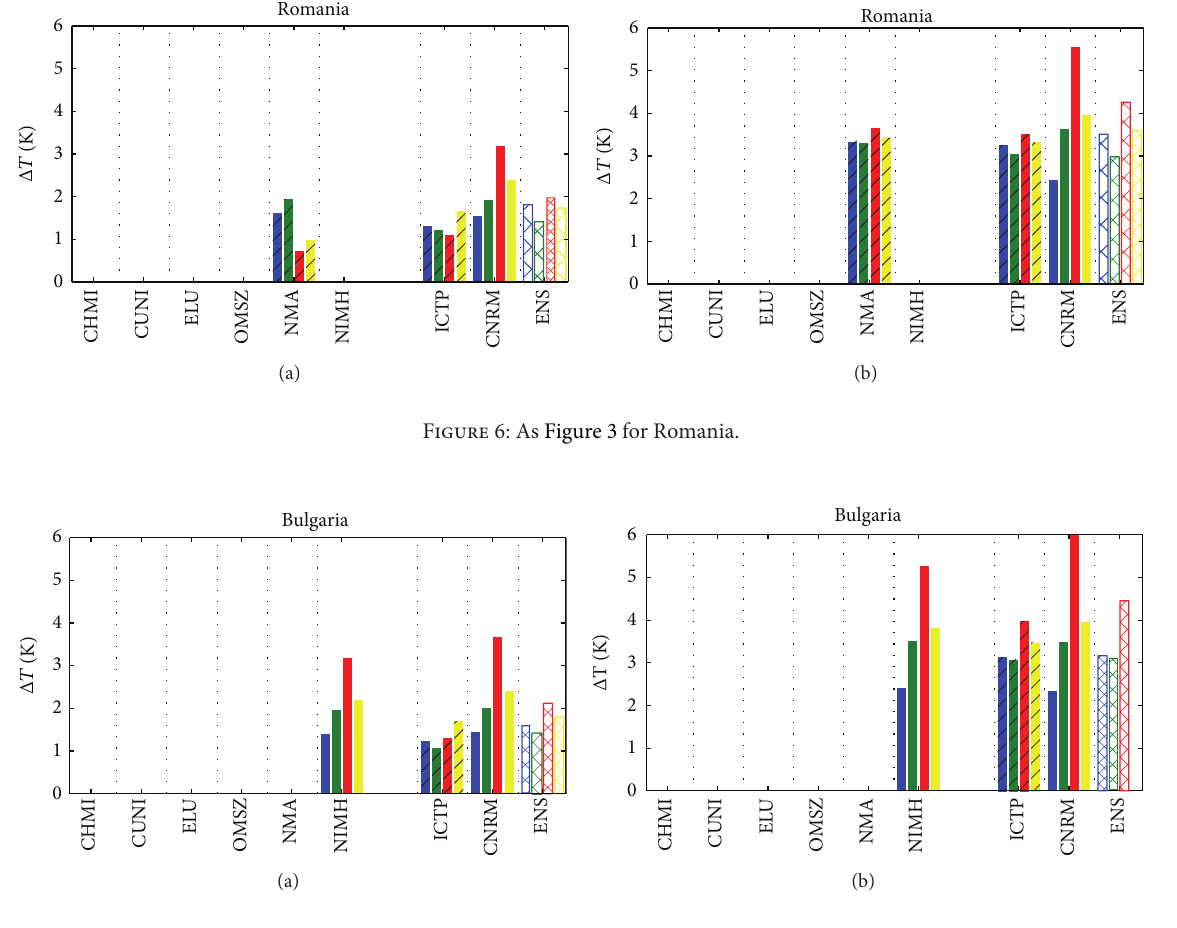
Figure 7: As Figure 3 for